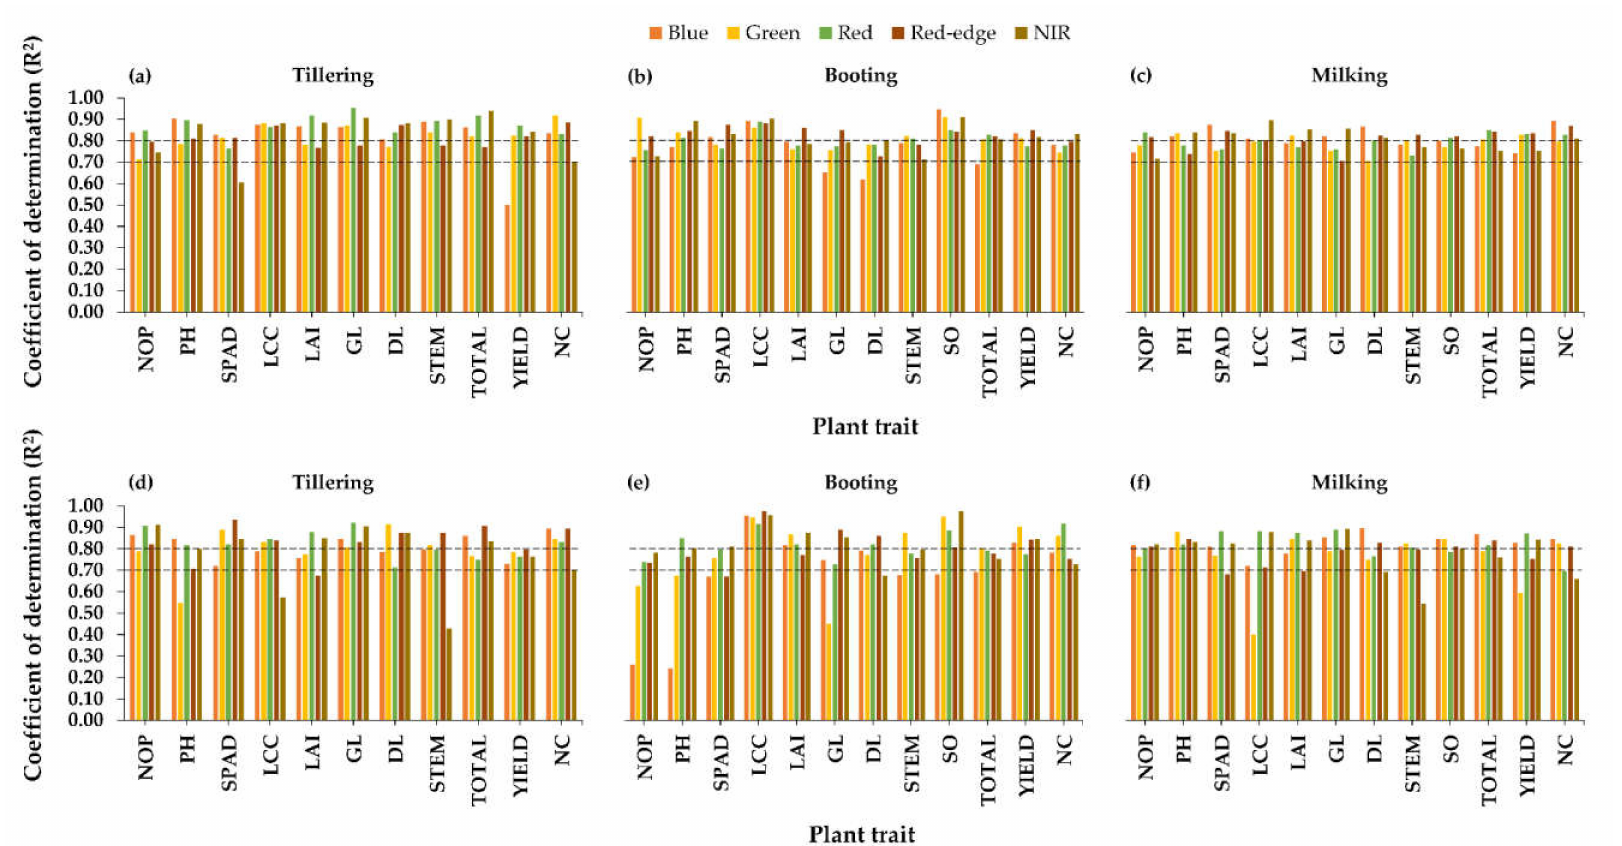
Figure 2. R 2 values for the raw band’s training ( a – c ) and testing ( d – f ) models for all plant traits at different rice growth